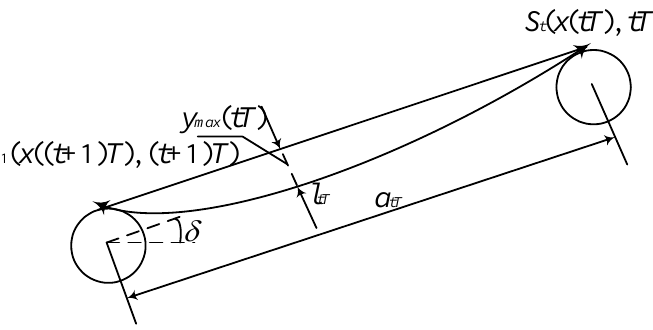
Figure 7. An overhang of the belt between adjacent idlers.